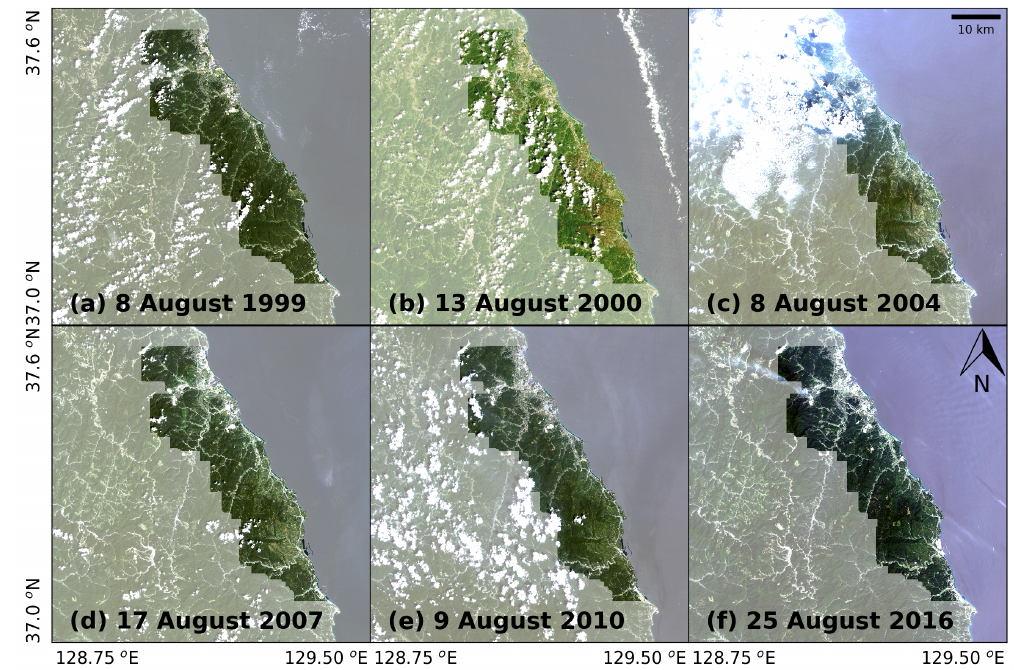
Figure 4. The RGB composite images of Landsat-5 and Landsat-8: ( a ) 8 August 1999; ( b ) 13 August 2000; ( c) 8 August 2004; ( d ) 17 August 2007; ( e ) 9 August 2010; ( f ) 25 August 2016. The values of NBR 2.1 , NBR 1.6 , NDVI, and GPP immediately dropped after the forest fire. The